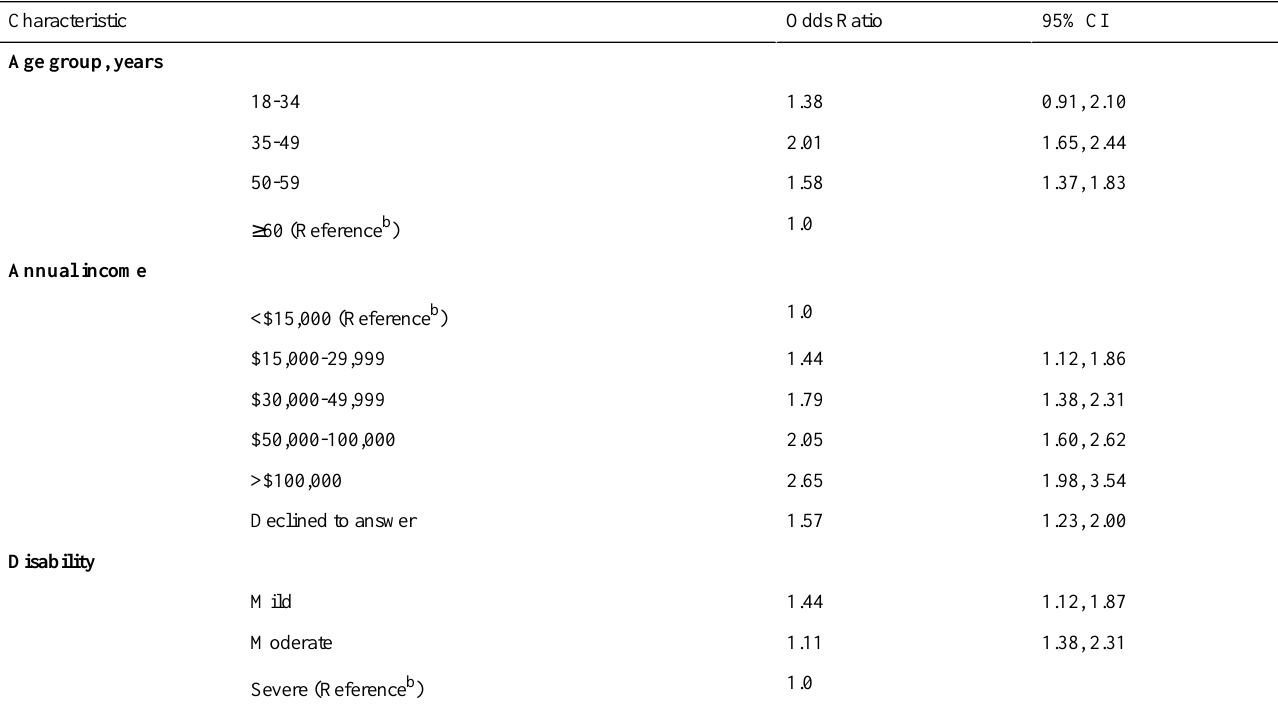
Table 3. Characteristics associated with using mass media versus interpersonal information sources as the first source of health information (n=6348).